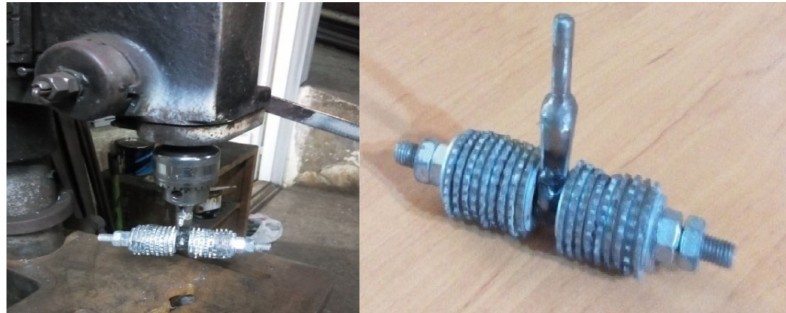
Figure 5. ASTM C944 chucked drill at the left and abrading cutter at the right.